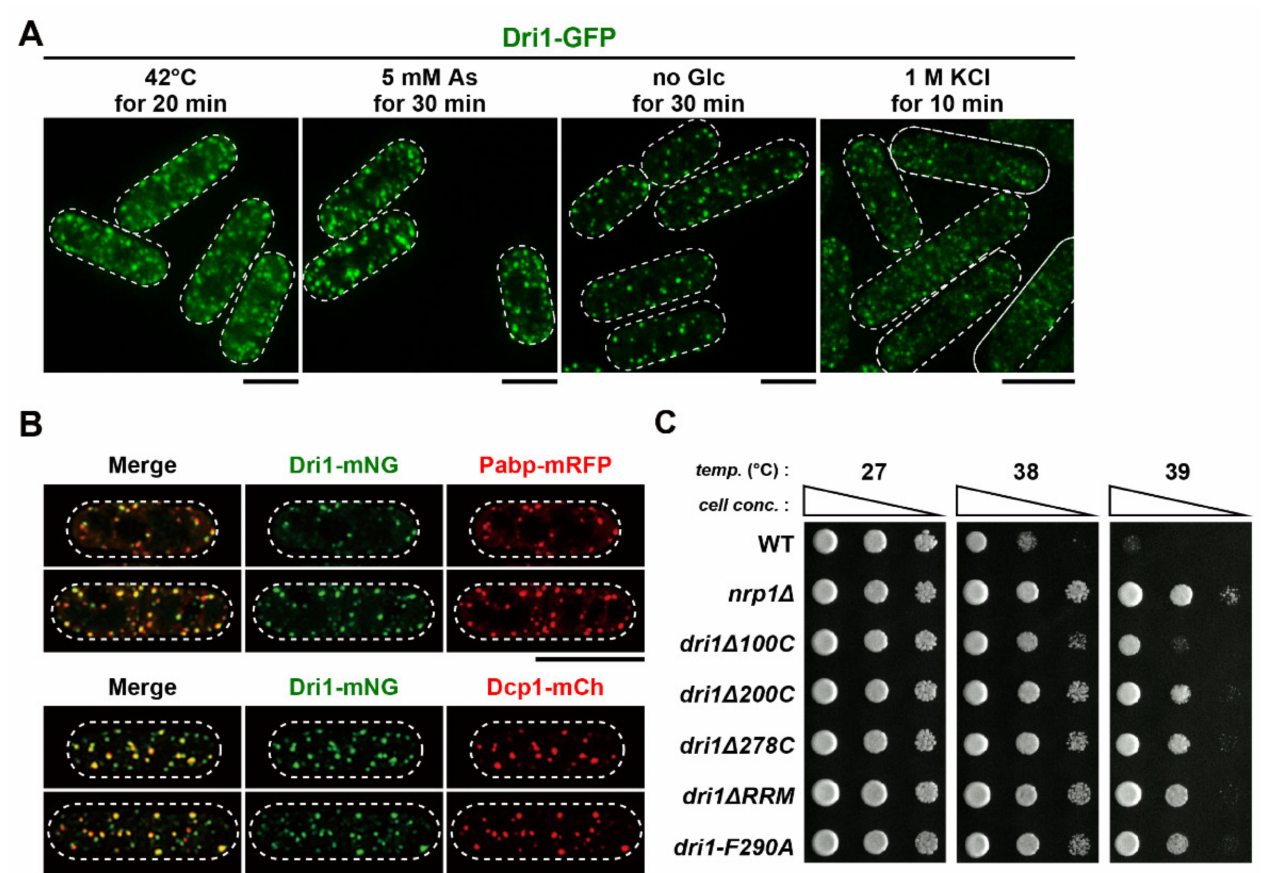
Figure 6. Dri1 accumulates at stress granules and limits the maximum temperature for growth. ( A ) Dri1 rapidly translocates to the cytoplasmic aggregates under various stress conditions. Cells expressing Dri1-GFP were grown in rich media at 27 ◦ C and then exposed to various stresses. ( B ) Dri1 co-localizes with an SG marker poly(A)-binding protein, Pabp and a P body marker, Dcp1 under glucose depletion condition. Cells expressing either Pabp-mRFP or Dcp1-mCherry, together with Dri1-mNeonGreen, were grown in rich media at 27 ◦ C and then shifted to glucose-depleted medium at 27 ◦ C for 30 min. ( C ) Malfunction of Dri1 acquires tolerance to high temperature stress. Indicated strains were serially (10-fold) diluted, spotted onto rich YE5S plates and incubated at various temperatures for 2–3 d. The cell peripheries are indicated with dotted lines. Scale bars, 10 µ